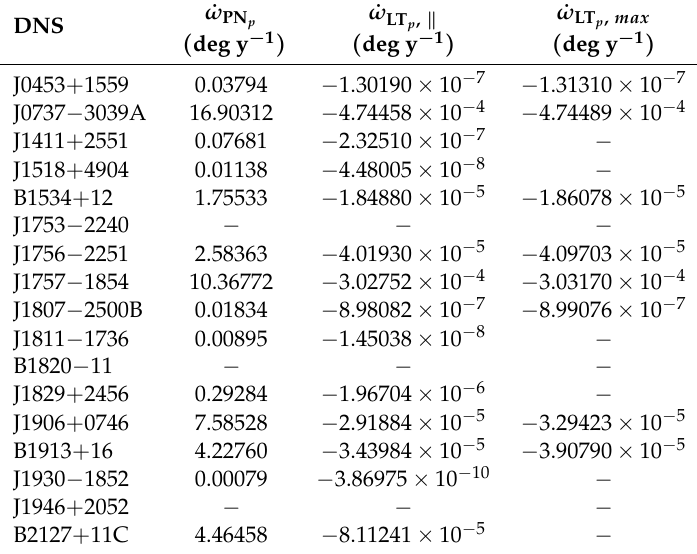
Table 2. Values of ˙ ω PN , ˙ ω LT and ˙ ω LT for known pulsars in DNSs using I p = 1.26 × 10 45 gm cm 2 p p , max p , (cid:107) and neglecting the Lense-Thirring effect of the companion. To show the difference between ˙ ω LT ˙ ω LT , I keep values up to five decimal places even for the cases where sin i is known with less accuracy. p , max ˙ ω PN ˙ ω LT ˙ ω LT DNS p p , max p , (cid:107) ( deg y − 1